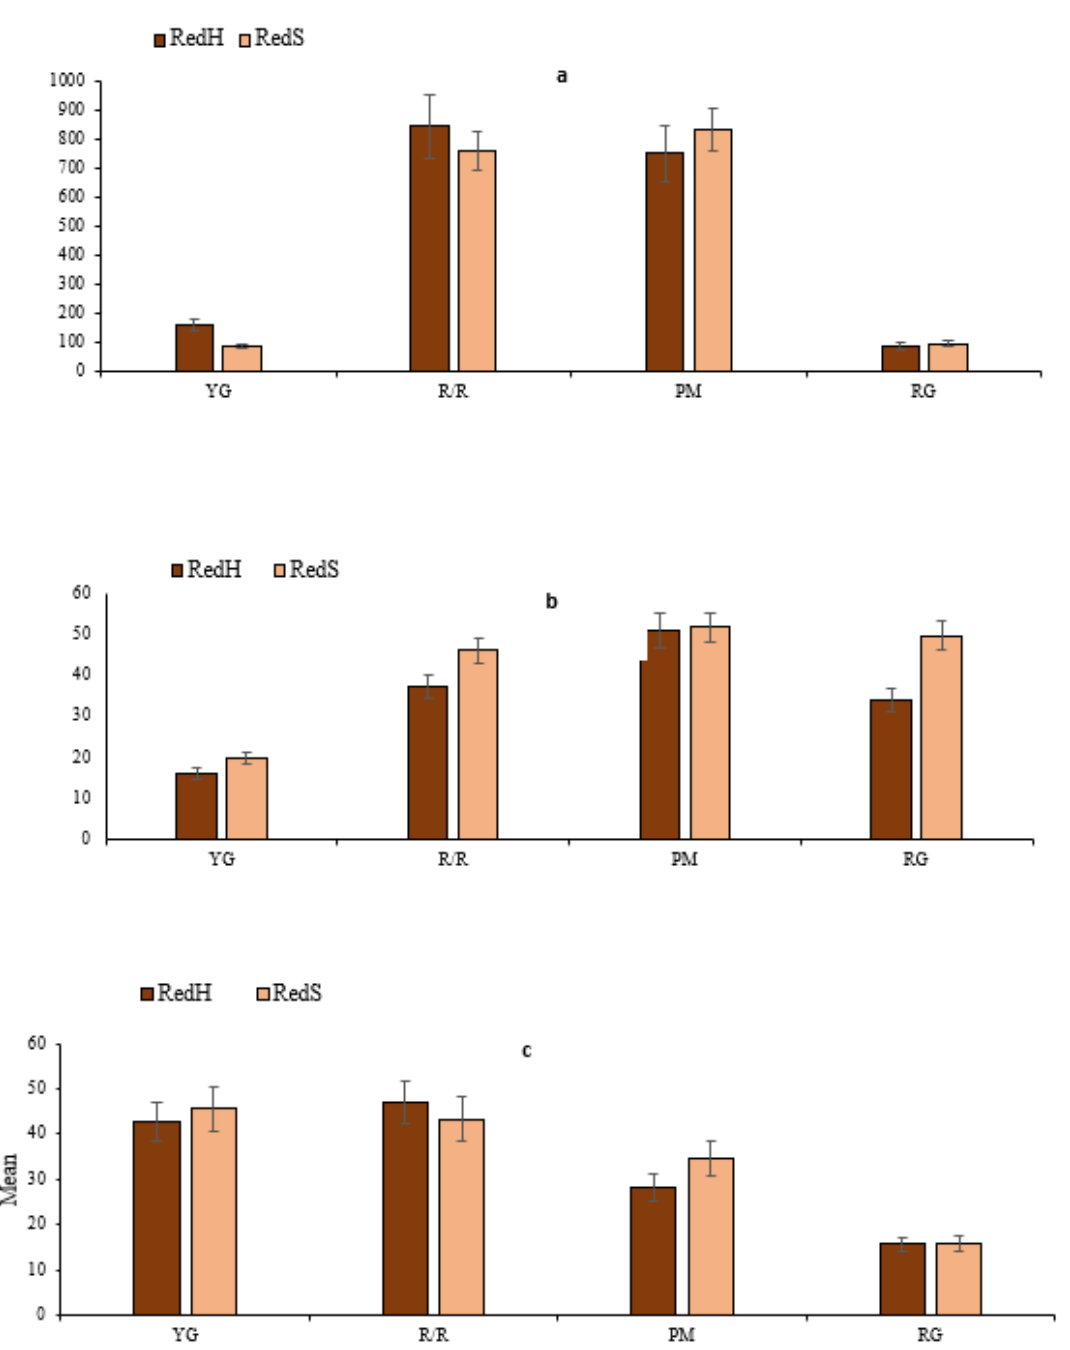
Figure 6. ( a – c ) The interaction bar of cooked potato cultivars with roasted pepper cultivars on bioactive compounds.